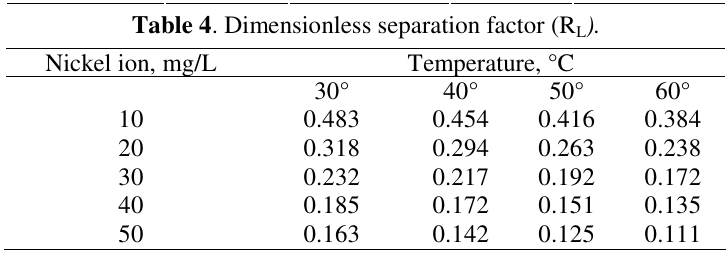
Table 4 . Dimensionless separation factor (R